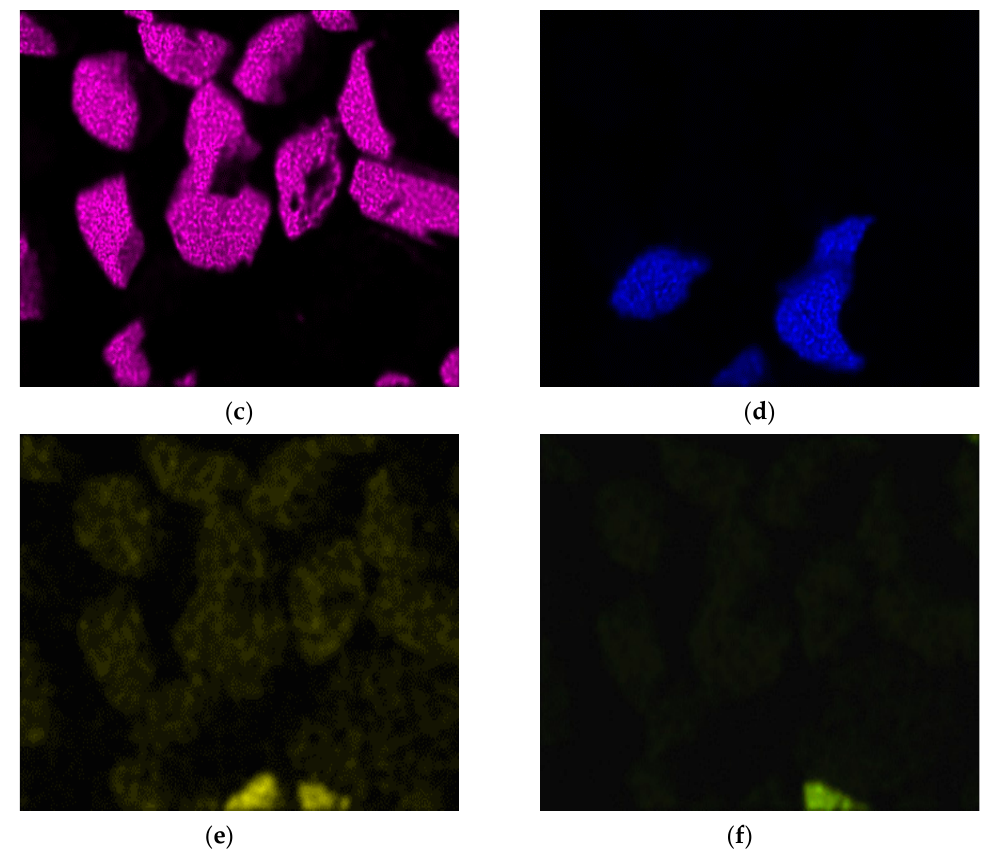
Figure 2. Distribution of the elements: ( a ) zirconium concentrate grains; ( b ) distribution of the elements on the surface; ( c ) zirconium; ( d ) titanium; ( e ) iron; ( f ) chromium.